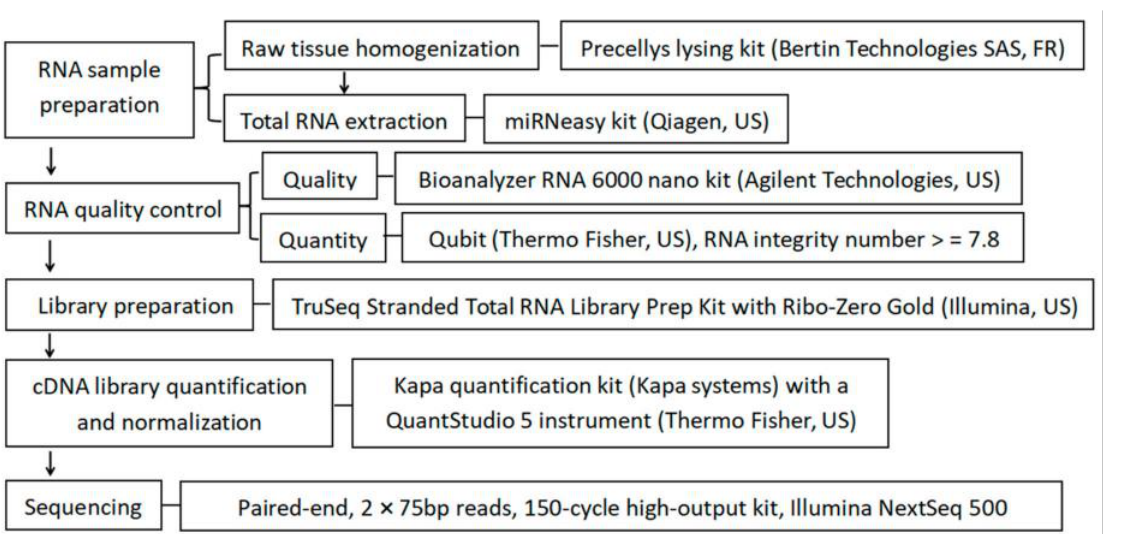
Figure 7. Workflow of RNA library preparation and sequencing.